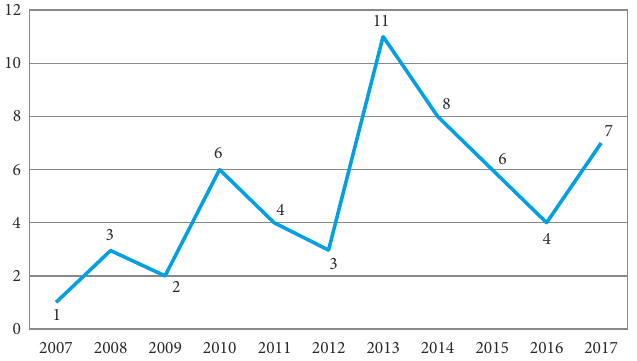
Figure 1. Papers published by